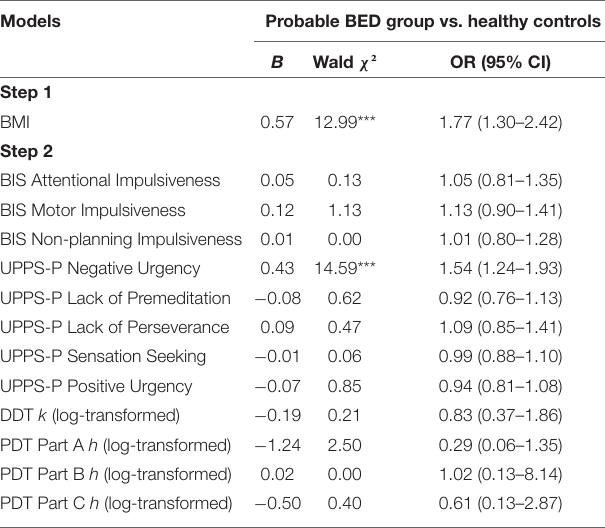
TABLE 4 | Logistic regression analyses of impulsivity scores on binge eating controlling for BMI ( N = 117).